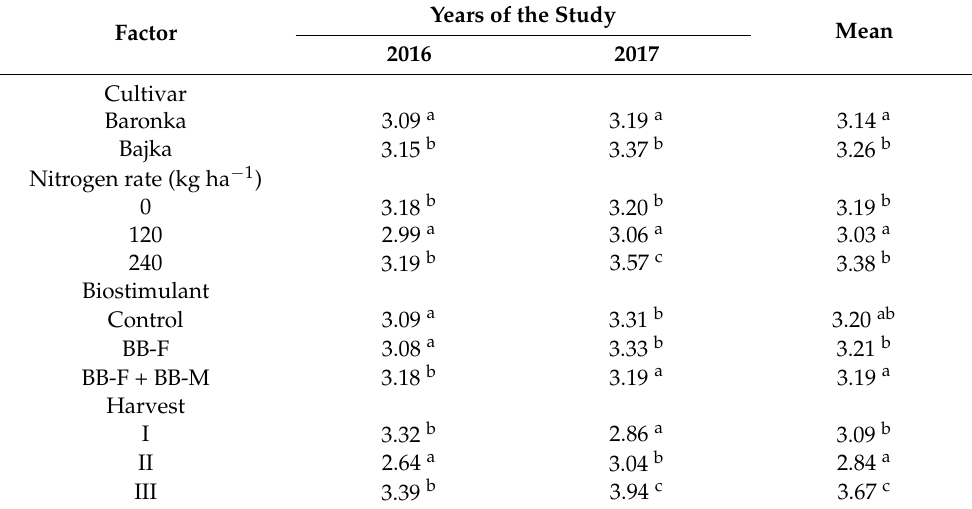
Table 5. Content of phosphorus in perennial ryegrass biomass (g kg − 1 DM). Years of the